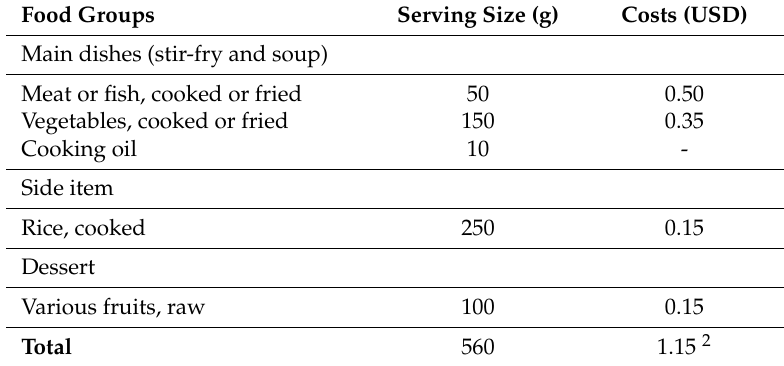
Table 3. Agreed serving sizes and costs of food groups in low-price model lunch sets served at a garment factory in Phnom Penh, Cambodia. 1